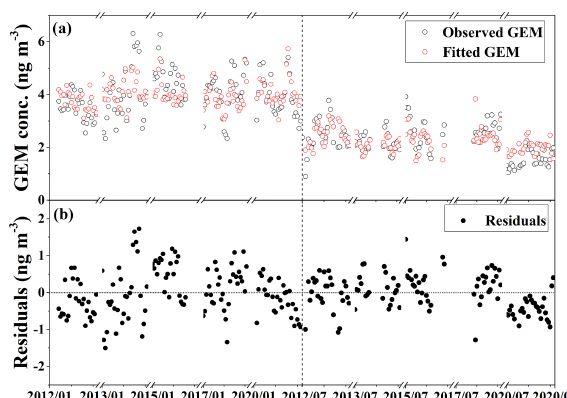
Figure 6. Time series of (a) observed and fitted GEM concentra- tions in January and July and (b) residual distribution during the whole study